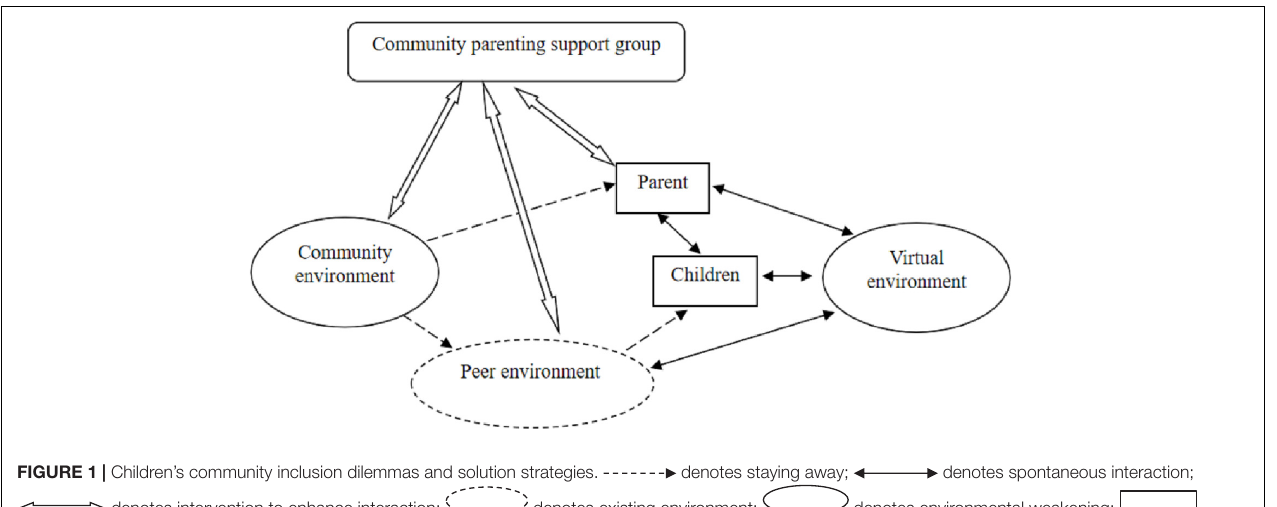
FIGURE 1 | Children’s community inclusion dilemmas and solution strategies. denotes staying away; denotes spontaneous interaction; denotes intervention to enhance interaction; denotes existing environment; denotes environmental weakening; denotes creating